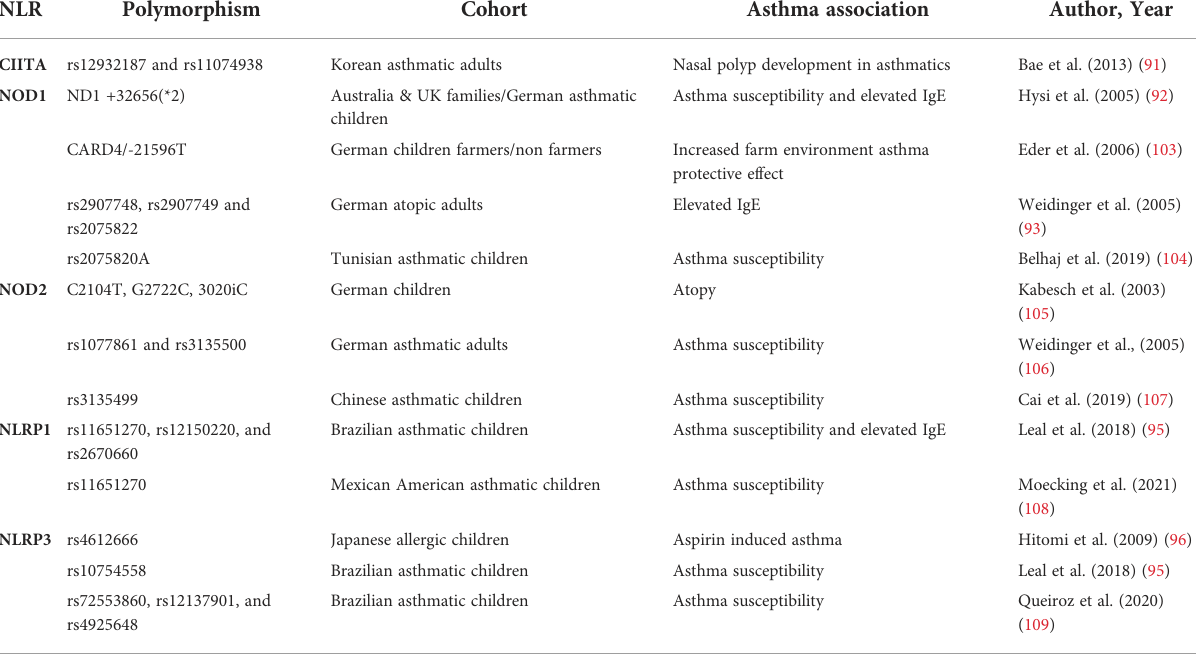
TABLE 1 Most relevant NLR-associated polymorphisms in